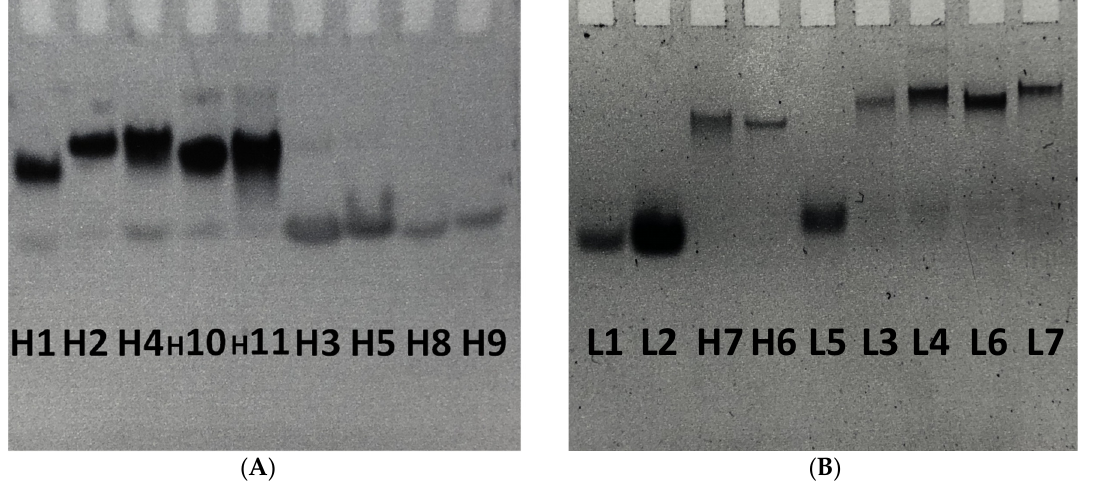
Figure 3. Native 12% PAGE of TBE 1X supplemented with 100 mM KCl using the same running buffer at 150 Watts maintaining a 20 °C for 4–5 h; stained with SYBR Green. ( A ) Short HIV G-rich sequences (H1, H2, H4, H10, H11) versus A-rich control sequences (H3, H5, H8, H9). ( B ) G-rich sequences carrying antiluciferase sequence (L3, L4, L6, L7) versus control single stranded sequences (L1, L2, L5) compared with short G-rich sequences (H6, H7).